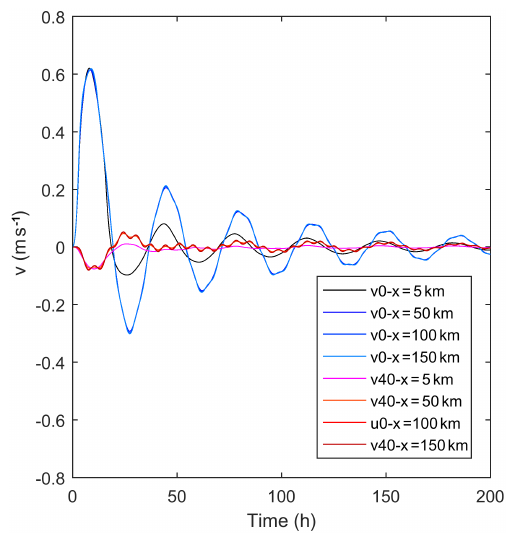
Figure 4. Time series of the northward velocity ( v) at different depths and positions. “v0” and “v40” mean v at depths of 0 and 40m.